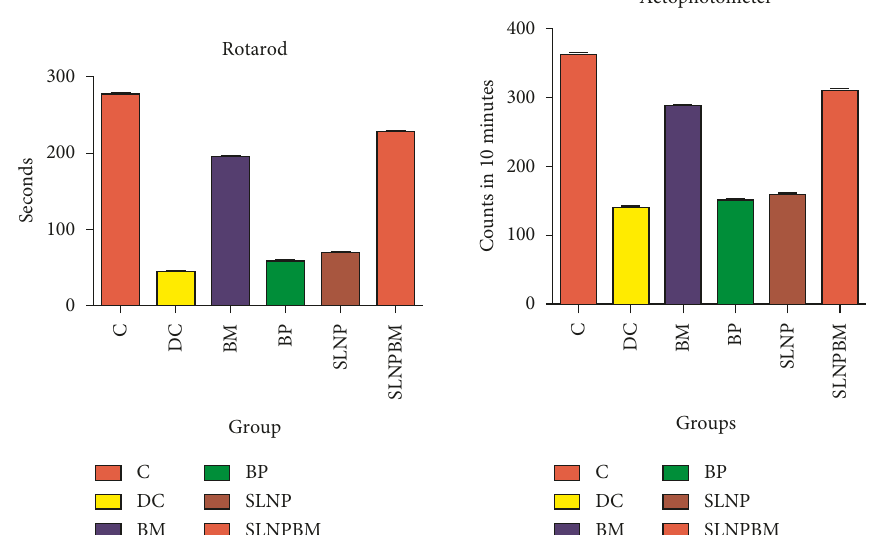
Figure 11: Effect of treatment on locomotor activity and muscle strength. ∗∗∗ represents P < 0 . 05 versus the control group. Data represented as mean ± SEM ( N � 6). C � control, DC � disease control, BM � pure Bacopa monnieri , BP � blank microneedle patch, SLNP � blank solid lipid nanoparticle loaded patch, and SLNPBM � Bacopa monnieri loaded solid lipid nanoparticle loaded